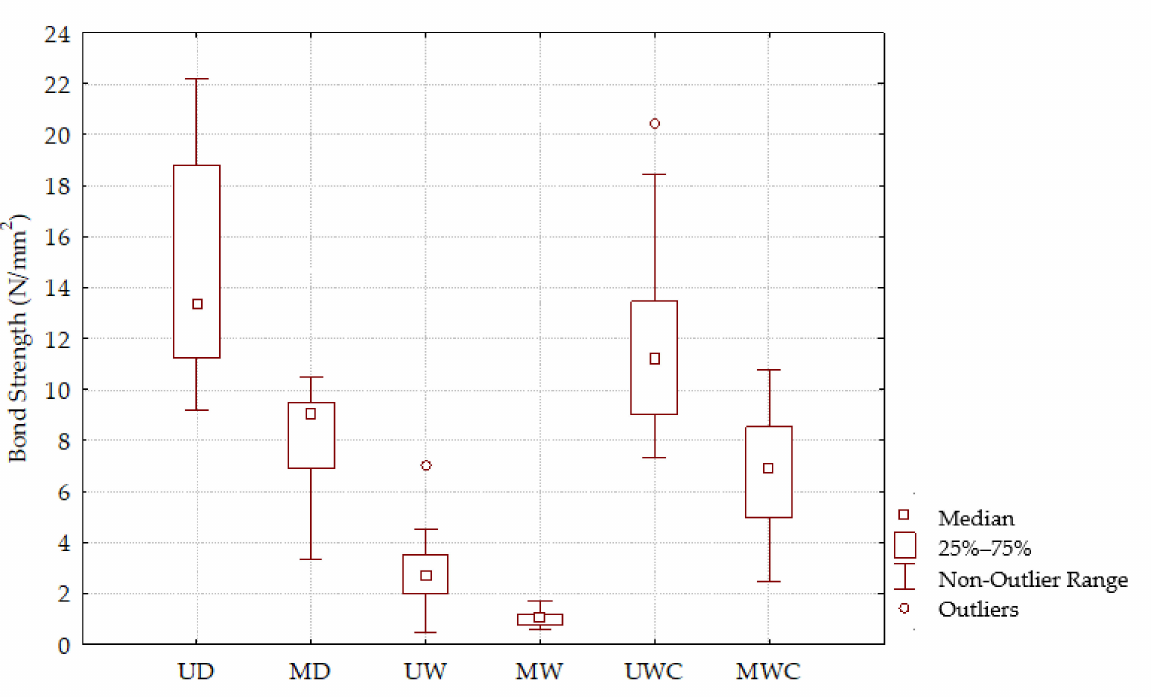
Figure 7. Bond strength of modified wood